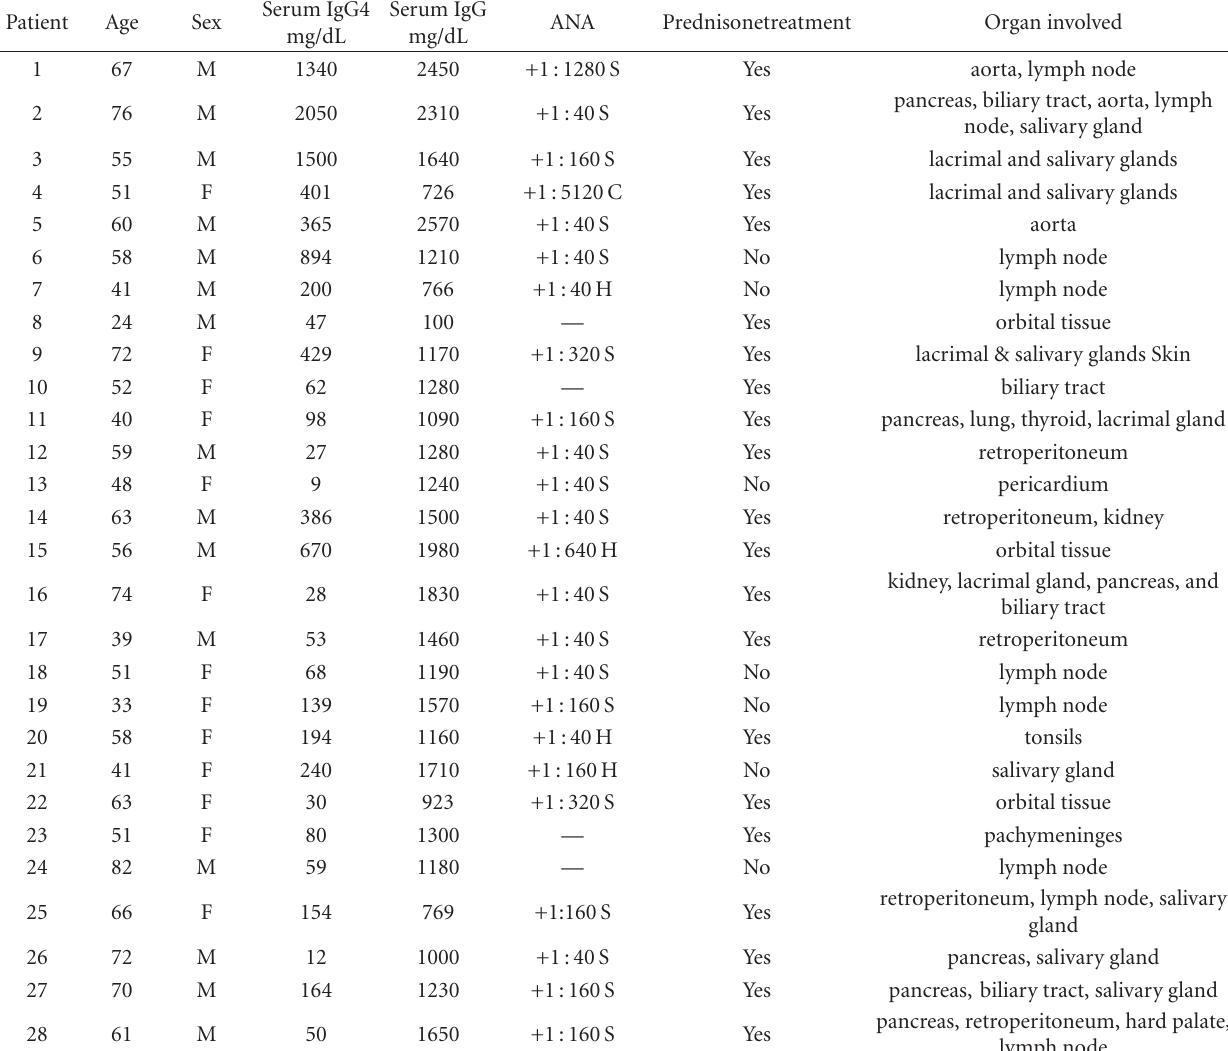
Table 1: IgG4-RD patients’